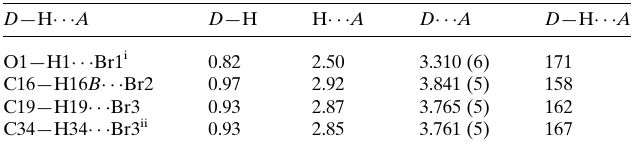
Table 1 Hydrogen-bond geometry (A˚ , (cid:4) ).